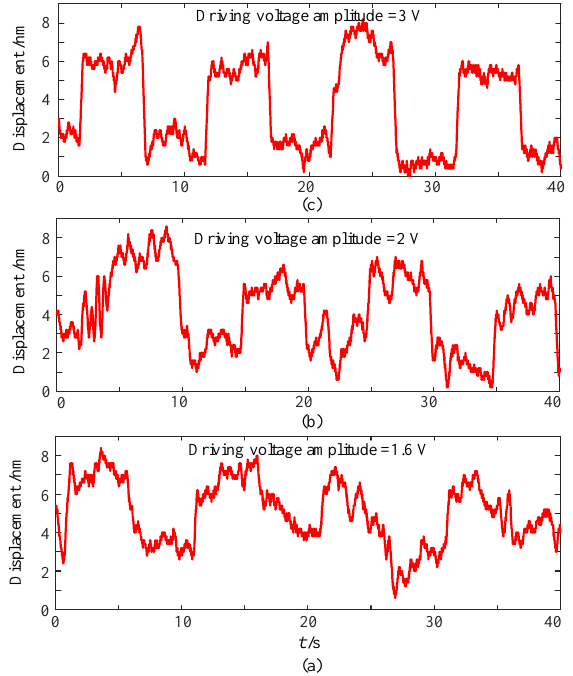
Figure 12. Resolution characteristics of the stage in scan operation mode. ( a )Driving voltage amplitude is 1.6 V. ( b ) Driving voltage amplitude is 2 V. ( c ) Driving voltage amplitude is 3 V.